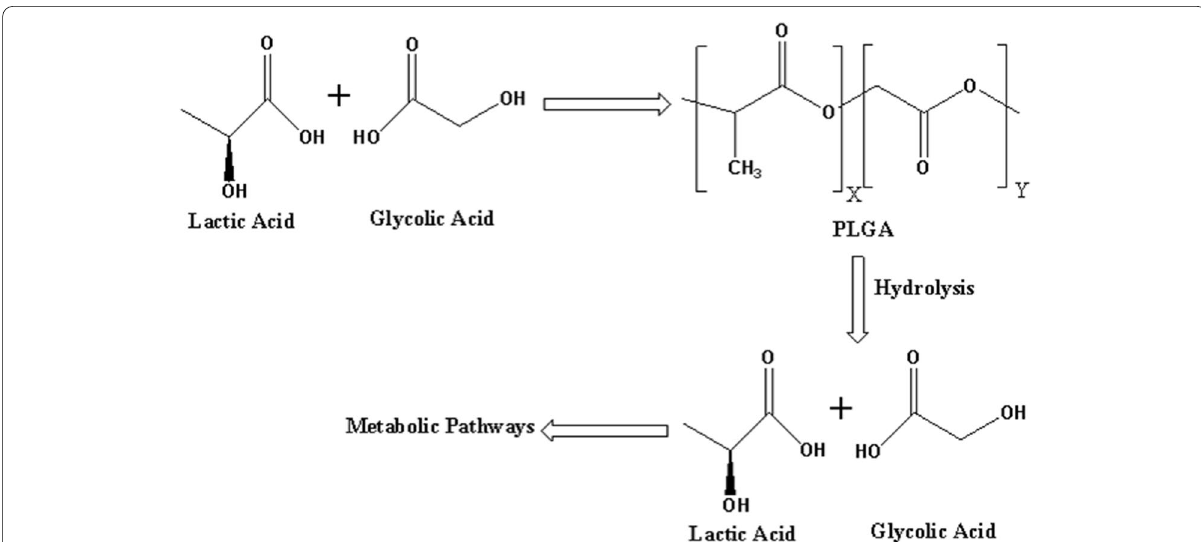
Fig. 2 Representation of synthesis and metabolism of PLGA where X and Y represent the number of lactic acid and glycolic acid units,